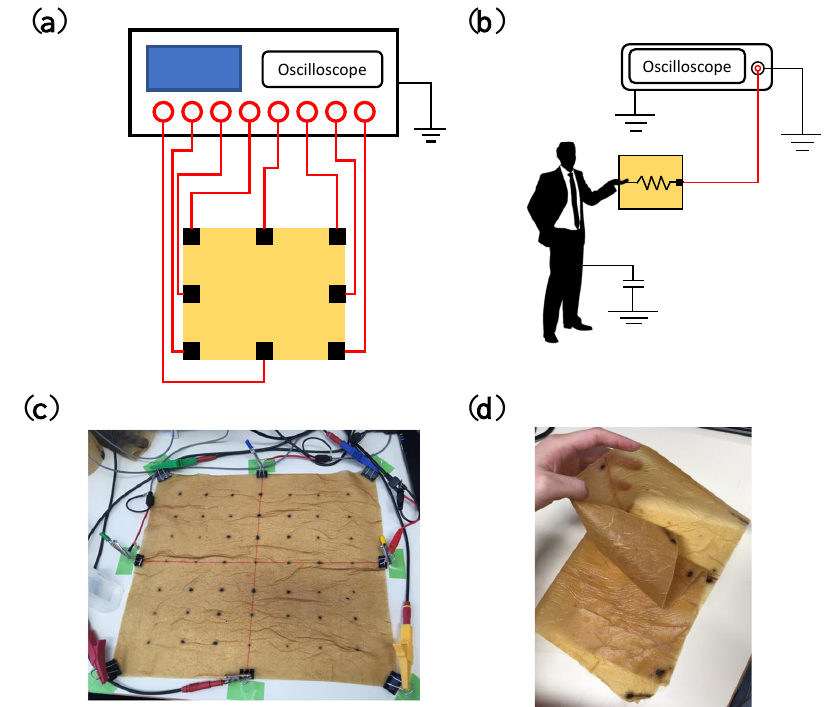
Figure 1. ( a ) Eight electrodes were attached to a semi-conductive paper. ( b ) A circuit was formed when a human touched the paper. ( c ) Photo of the paper (40 × 36 cm 2 ) with the electrodes attached. ( d ) The paper was dry, flexible, and